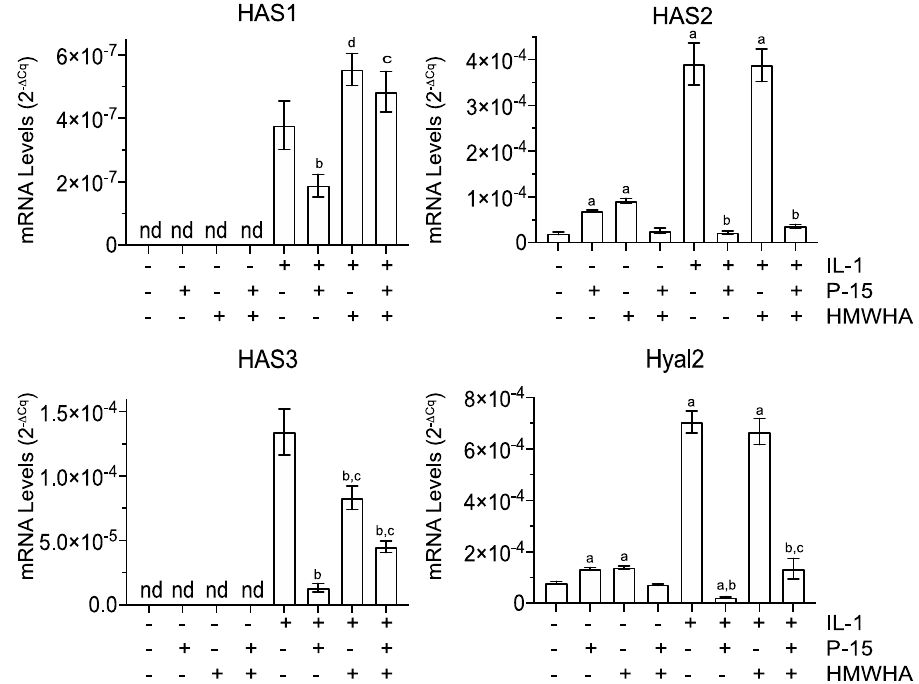
Figure 4. mRNA levels of HA synthase enzymes (HAS1, HAS2, and HAS3) and the HA–degrading enzyme Hyal2 in vehicle–treated or IL–1 β –treated human BMSCs cultured in the absence or presence of P15–1 and HMWHA. Human